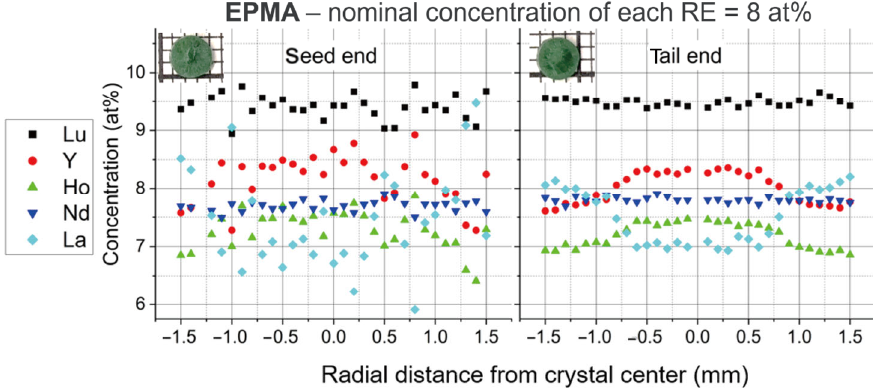
Fig. 8 EPMA radial concentration profiles of seed end (left) and tail end (right) of crystal 2. The legend on the left applies to both graphs. On the vertical axis, − 1.5 and 1.5 mm correspond to the last measurement toward the outer surface of the crystal; zero corresponds to the center of the crystal.